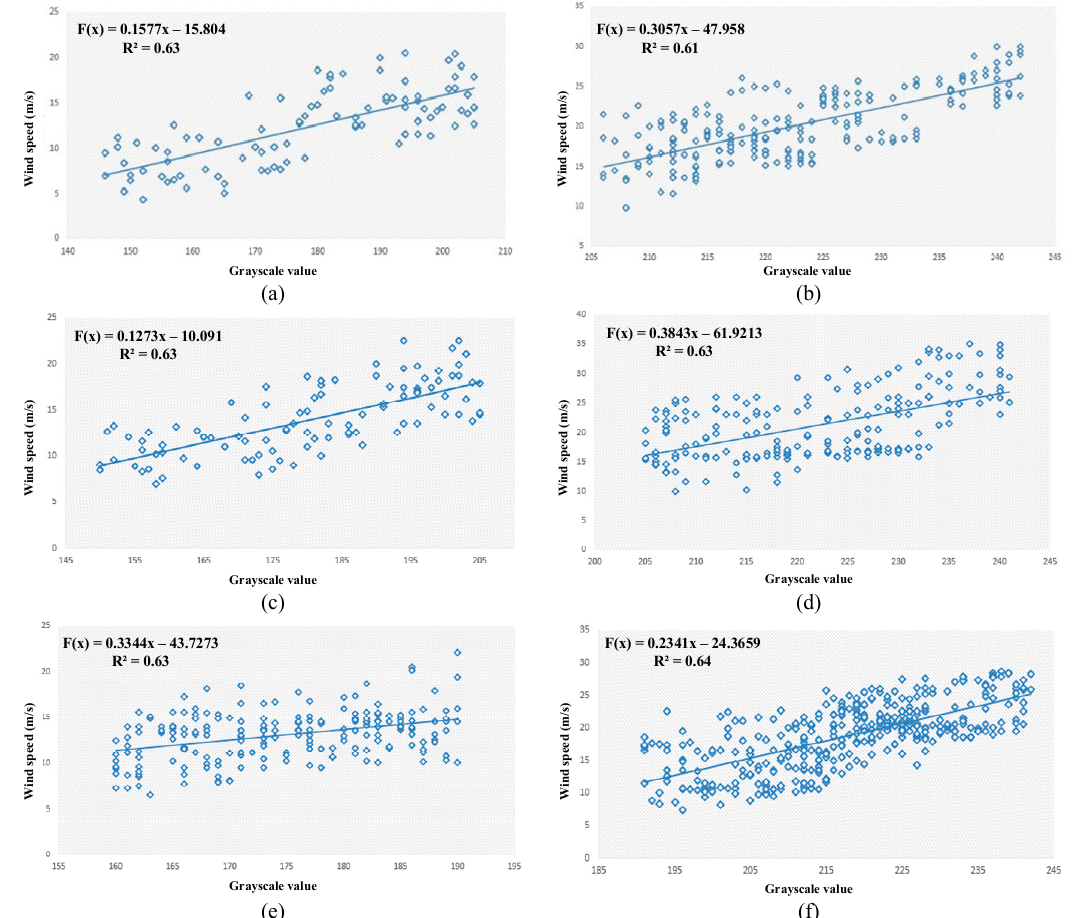
Figure 6. Piecewise regression model results: ( a ) the second segment result of Usagi; ( b ) the third segment result of Usagi; ( c ) the second segment result of Fitow; ( d ) the third segment result of Fitow; ( e ) the second segment result of Nari; ( f ) the third segment result of Nari.